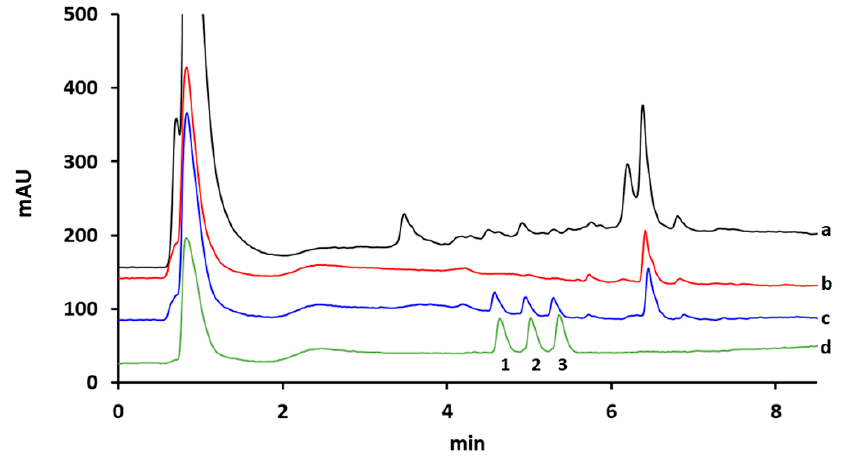
Figure 6. HPLC chromatograms of non-spiked river water extracted with ( a ) C 18 cartridge and ( b ) MIP cartridge, ( c ) spiked river water at 10 µ g L − 1 concentration level extracted with MIP cartridge and ( d ) the corresponding standard solution. Peak identifications: 1, colistin B; 2, colistin A; 3 polymyxin B.